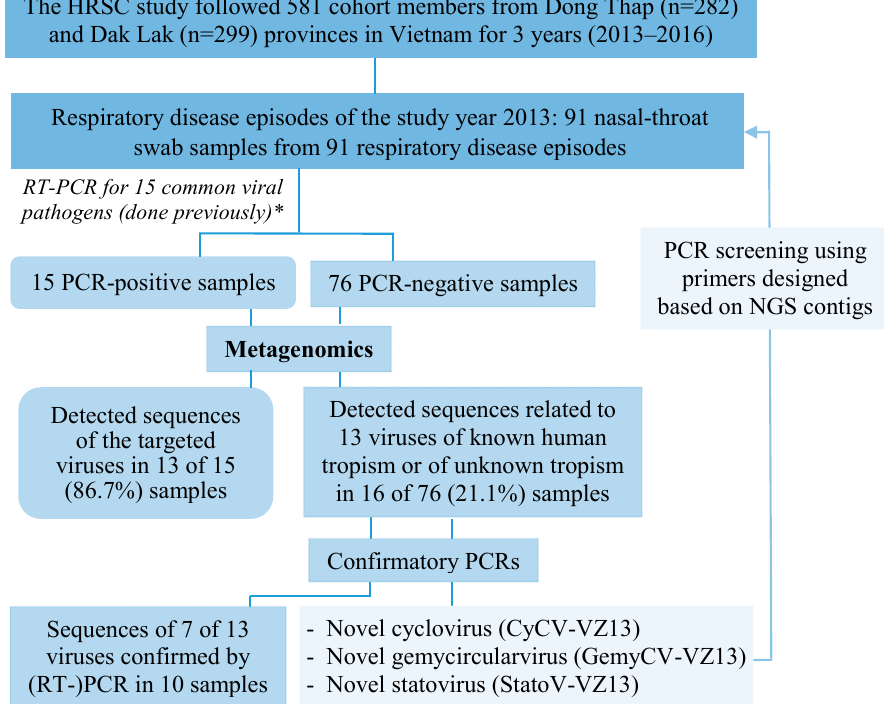
Figure 1. Overview of the methods and main results. HRSC: high risk sentinel cohort. * see [5], the 15 viruses include human rhinovirus (HRV), enterovirus (EVs), coronavirus (CoV) subtype OC43 and NL63, respiratory syncytial virus (RSV) A, RSV B, human metapneumovirus (MPV), influenza A virus, influenza B virus, adenovirus, parainfluenza virus (PIV)1–4, human bocavirus, and parechovirus.